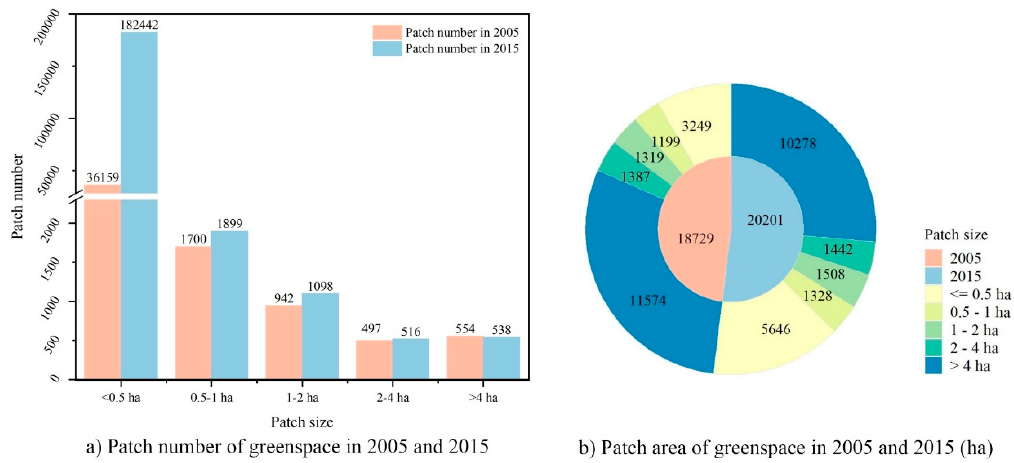
Figure 5. Change in differently sized greenspace patches from 2005 to 2015.